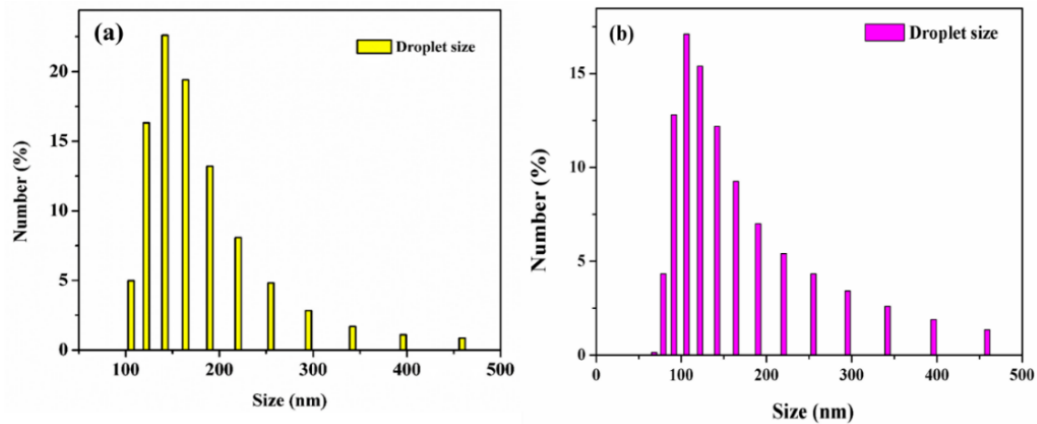
Figure 7. ( a ) Particle size distribution of hexadecane oil in water emulsion in the feed and ( b ) particle size of the SDS-stabilized hexadecane oil in water emulsion in the feed. Table 1. Residual TOC rates of raw n- hexadecane oil and SDS-stabilized n-hexadecane oil emulsion in permeate for different samples.